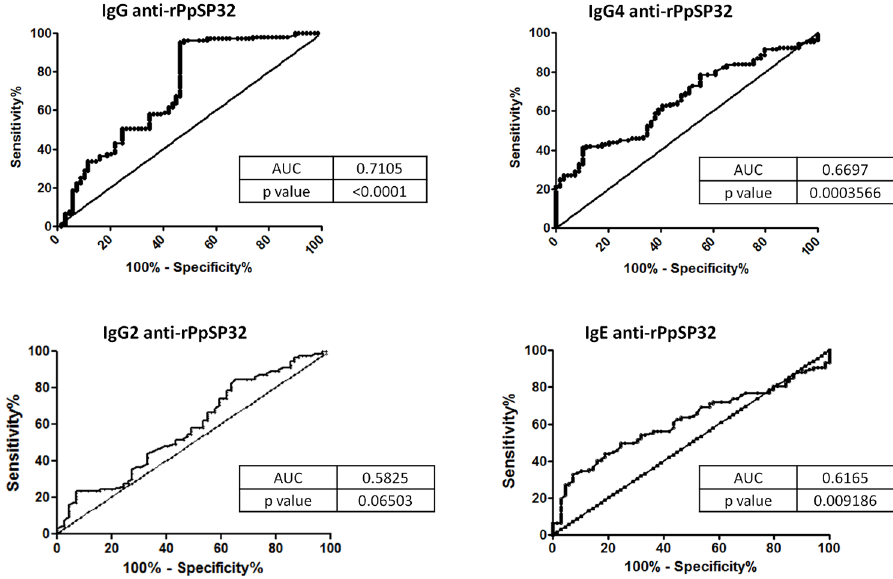
Fig 5. ROC curves predicting ELISA positivity against rPpSP32 for IgG, IgG subclasses and IgE. Levels of IgG, IgG2, IgG4 and IgE antibodies directed against P . papatasi SP32 were studied in serum samples of 176 representative participants. The area under curves (AUC) and the p value of the ROC curve are shown.